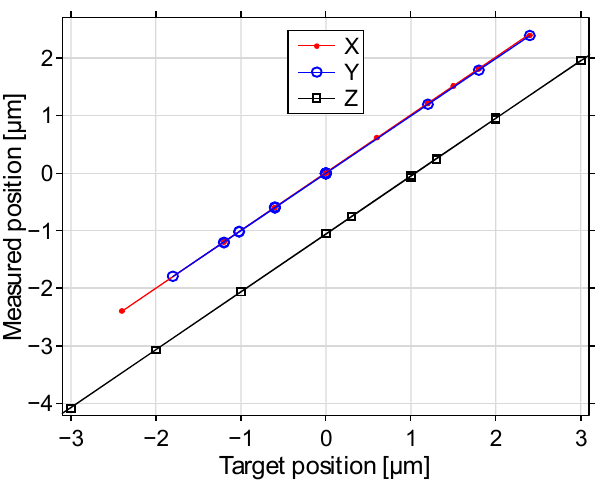
Figure 10. Measured positions versus target positions (𝑋, 𝑌, 𝑍) . The axial position is biased by the reference defocus.